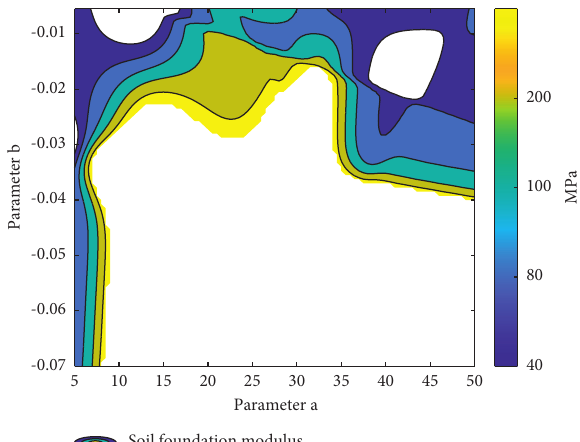
Figure 19: Values of parameters a and b under different soil foundation elastic modulus.